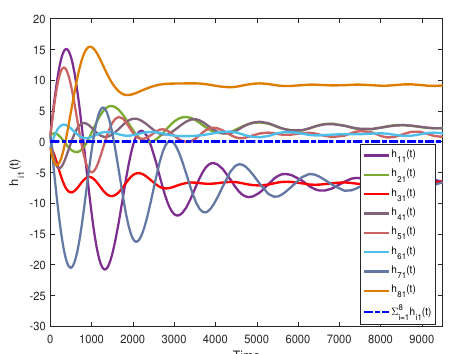
Figure 12. The trajectories of y i 2 ( t ) .